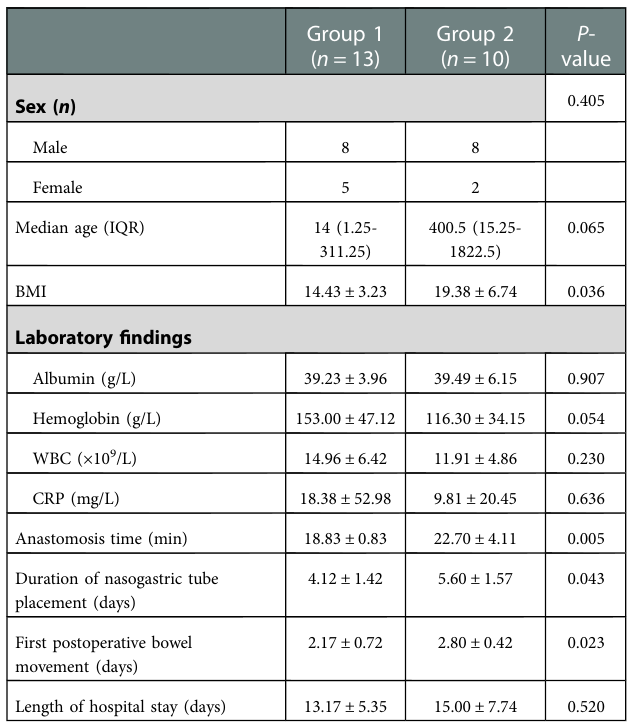
TABLE 1. Demographic and clinical